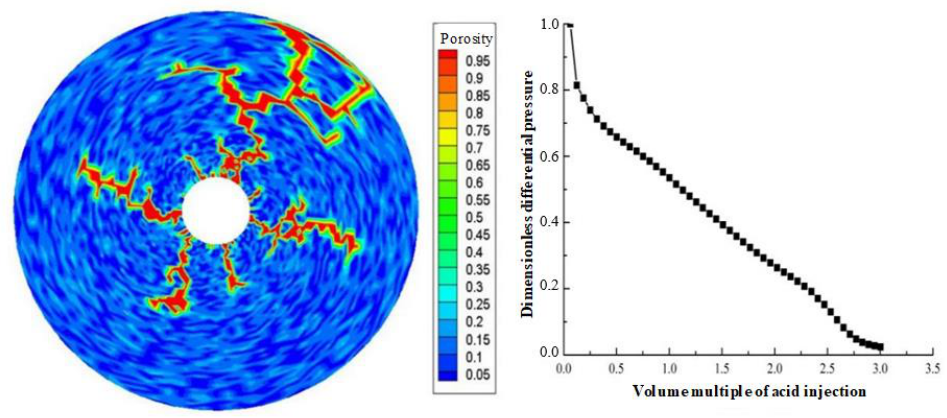
Figure 6. Change of dissolution form and differential pressure with gelling acid injection (gelling acid injection speed 1.35 cm/min).